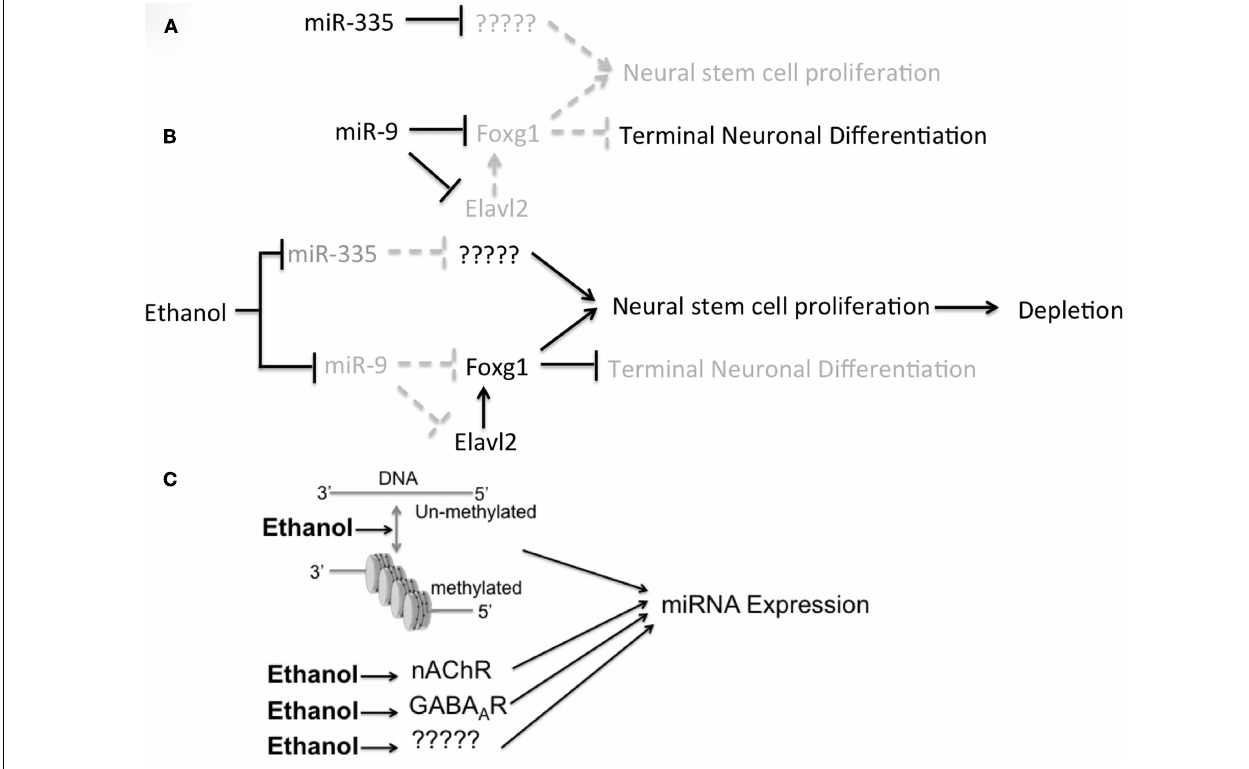
FIGURE 2 | Model for miRNA-mediated effects of ethanol on NSC maturation and ethanol regulation of miRNAs. (A) MiRNAs like miR-9 and miR-335 may repress NSC proliferation and promote maturation by repressing specific mRNA networks. (B) Ethanol represses these miRNAs in fetal NSCs, and would be projected to attenuate terminal neuronal maturation and